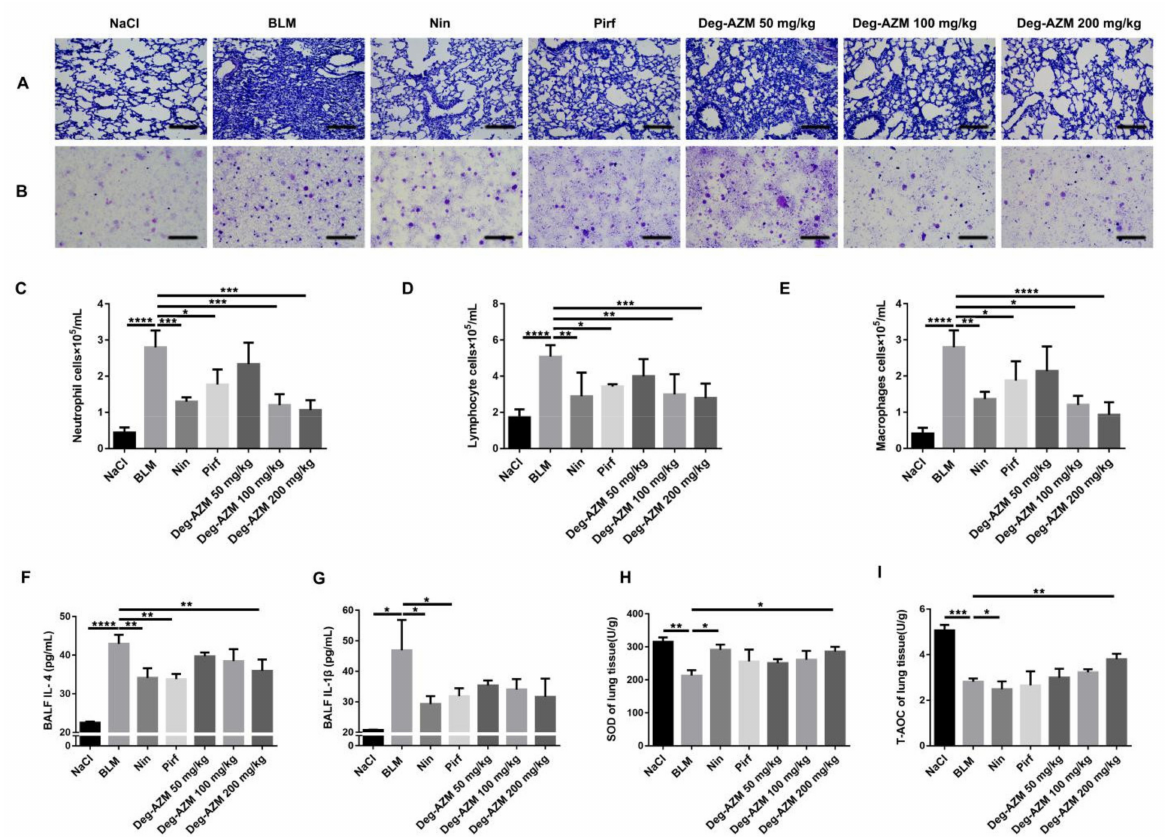
Figure 3. Deglycosylated azithromycin suppresses the inflammatory response and oxidative stress in vivo . ( A ) H&E staining of left lung tissues in each group. ( B ) H&E staining of inflammatory cells in the BALF. ( C – E ) Neutrophils, lymphocytes and macrophages from BALF in each group were counted on day 7. ( F , G ) Effects of deglycosylated azithromycin in Figure 4 and IL-1 β in BALF. Cytokines in BALF were determined using ELISA. ( H , I ) Effects of deglycosylated azithromycin oxidative stress induced by BLM. The experiments were performed with three technical replicates and two biological repeats. Data are presented as the means ± SD ( n = 8). Comparisons between groups were achieved using one-way analysis of variance (ANOVA). * p < 0.05, ** p < 0.01, **** p <